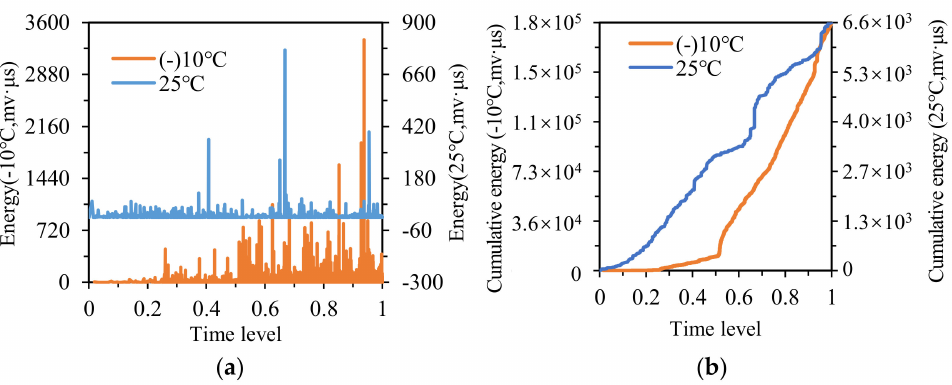
Figure 12. The energy and cumulative energy distribution of OGFC at − 10 ◦ C and 25 ◦ C: ( a ) energy; ( b ) cumulative